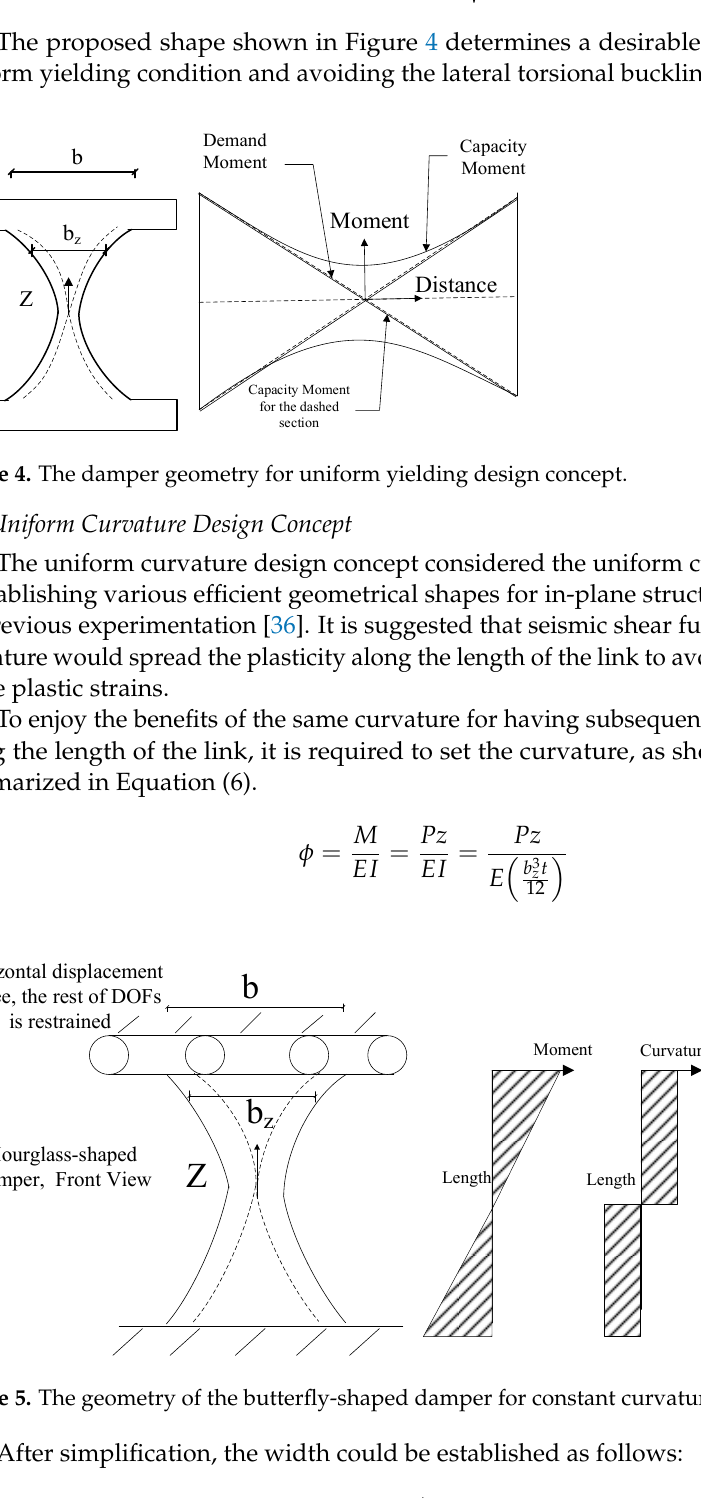
Hourglass-shaped Damper, Front View Figure 6. The constant curvature concept. 2.3. Limit States and Ductile Based Design Concept The elaborated guideline in this section is proposed to determine the procedures to design various dampers with different shapes, as shown in Figure 7 for use in seismic structural fuses [14,15]. The provided guidelines improve the energy dissipation capability of the shear dampers by having the flexural modes as the dominant mode of behavior for ductile per- formance. It is shown that butterfly-shaped dampers with the dominant flexural mode of behavior are able to dissipate energy efficiently with full hysteretic behavior while the plastic strain concentration areas would occur far from the sharper geometrical changes, which leads to a lower probability of fracture protentional [15].